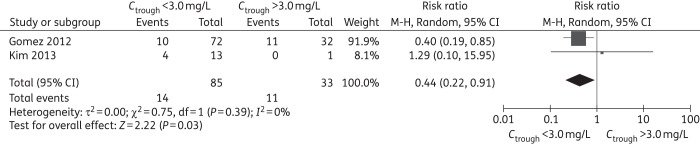
Meta-analysis for all-cause mortality (trough concentration of <3.0 mg/L comparison with >3.0 mg/L, RR <1 favours Ctrough <3.0 mg/L).